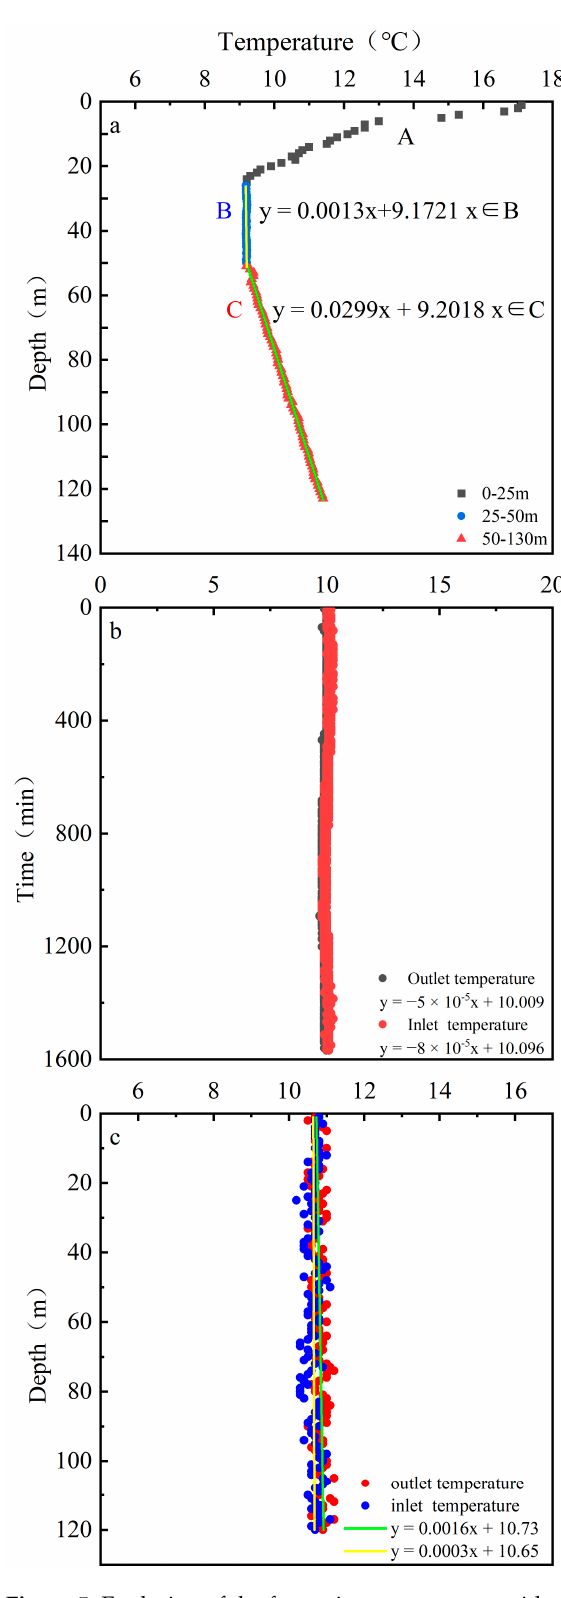
Figure 5. Evolution of the formation temperature with depth. ( a ) Temperature profile with drilling depth before water circulation. ( b ) Inlet and outlet temperatures after stable water circulation without a heater. ( c ) Formation temperature profile after water circulation.